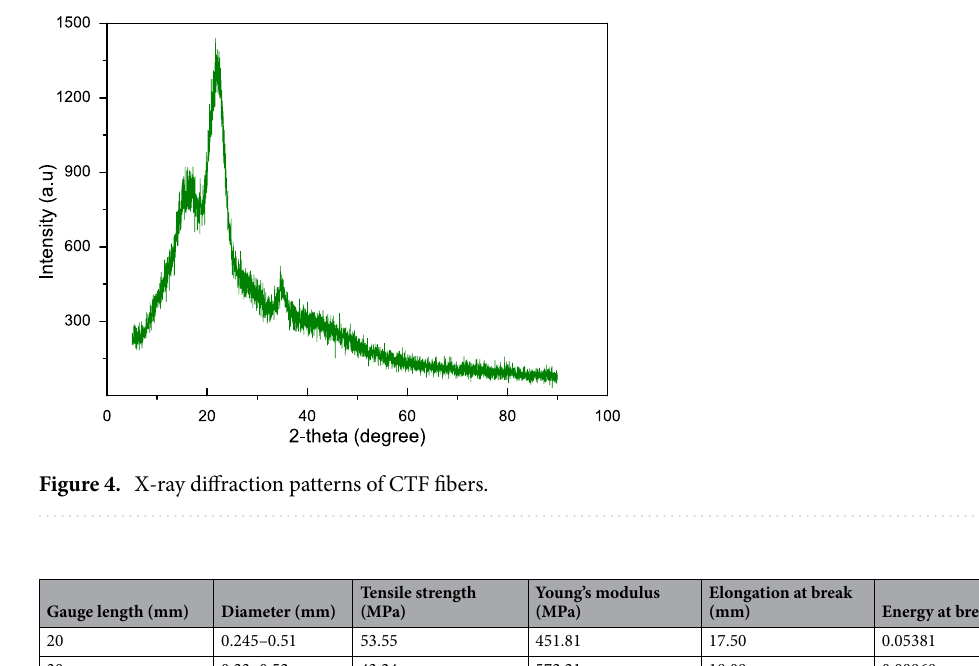
Gauge length (mm) Diameter (mm)